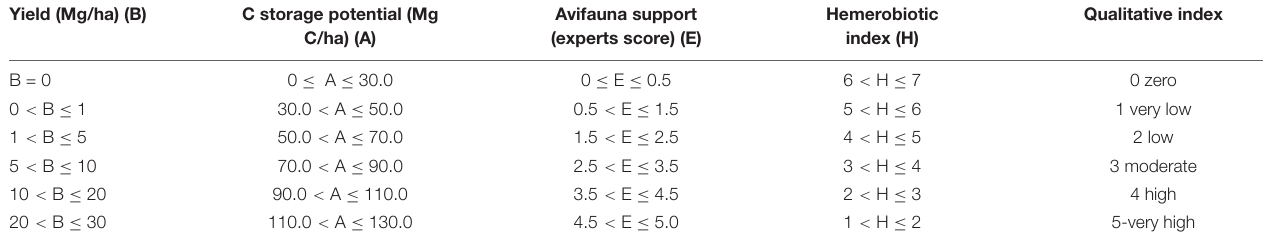
TABLE 2 | The qualitative index to convert each of the 4 indicators values to a 0–5